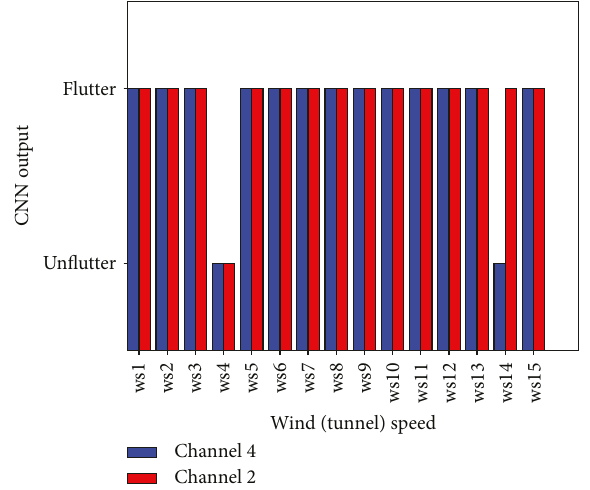
Figure 11: Symmetrical structures in fl utter test